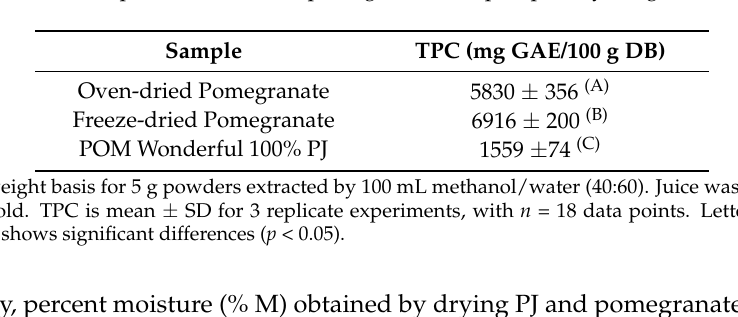
Figure 2. Total antioxidant capacity for pomegranate samples. Pomegranate juice ( A ) was analyzed by iRAC at pH 7.0 & 4.5 (IRACPJpH7, IRACPJpH4.5) or ABTS method (ABTSPJpH7.0). Pomegranate extract ( B ) from freeze-dried (FzD) or oven-dried (OvD) powder was analyzed by iRAC or ABTS methods (iRACOvDpH4.5, ABTSFzDpH7.0 etc.). Data shows mean ± SD for n = 12 points. Bars with different letters show significant differences ( p < 0.05).